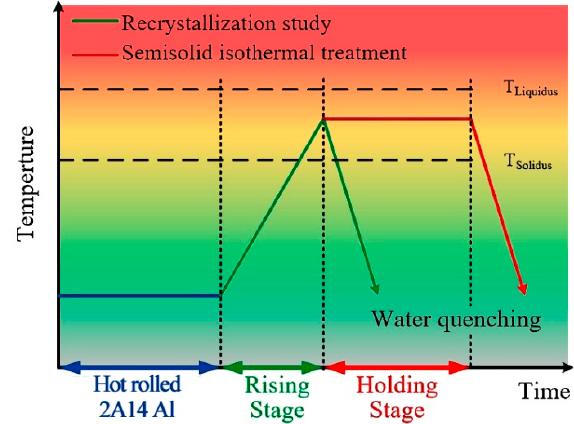
Figure 2. Schematic illustration of the WADSSIT process.